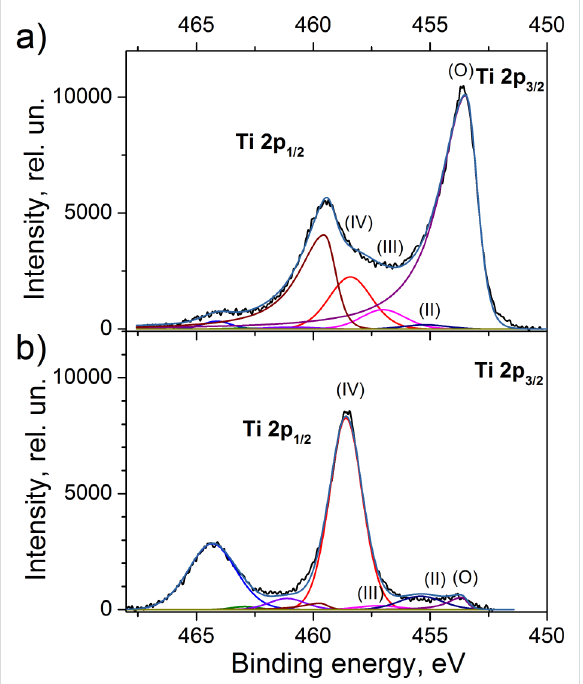
Figure 4: High-resolution XPS spectra of the Ti 2p peak of a) Ti clus- ters without oxygen treatment (type 1) and b) Ti clusters in-flight oxidized by RF plasma (type 3) measured immediately after the depo- sition. For better clarity, the Ti states are only presented for the Ti 2p 3/2 peak.